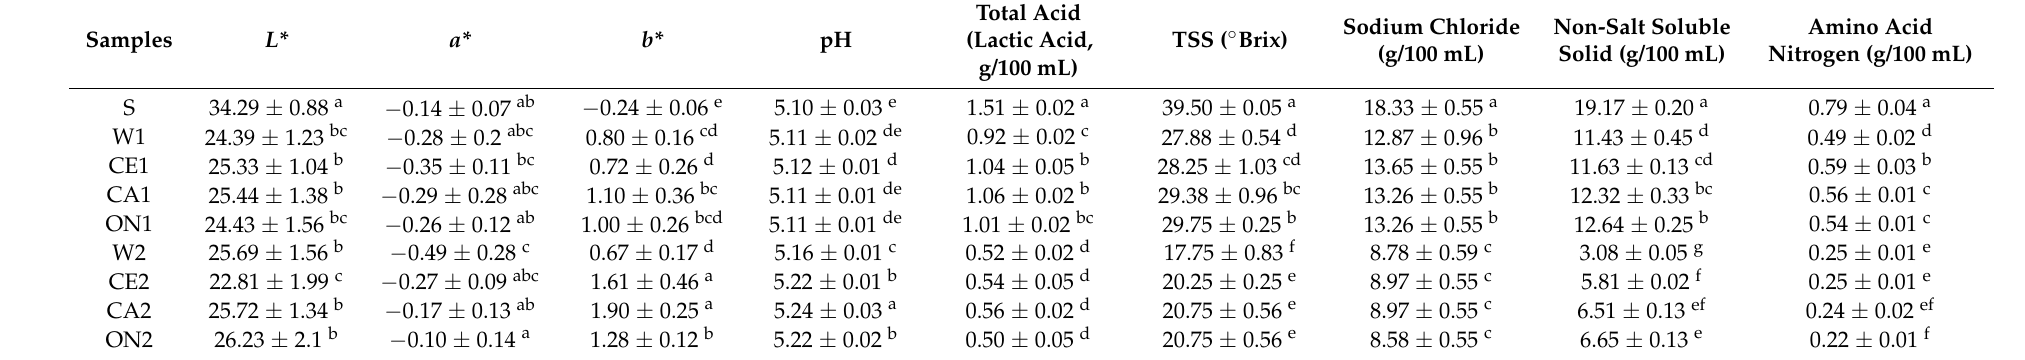
Table 3. Basic physicochemical parameters of different soy